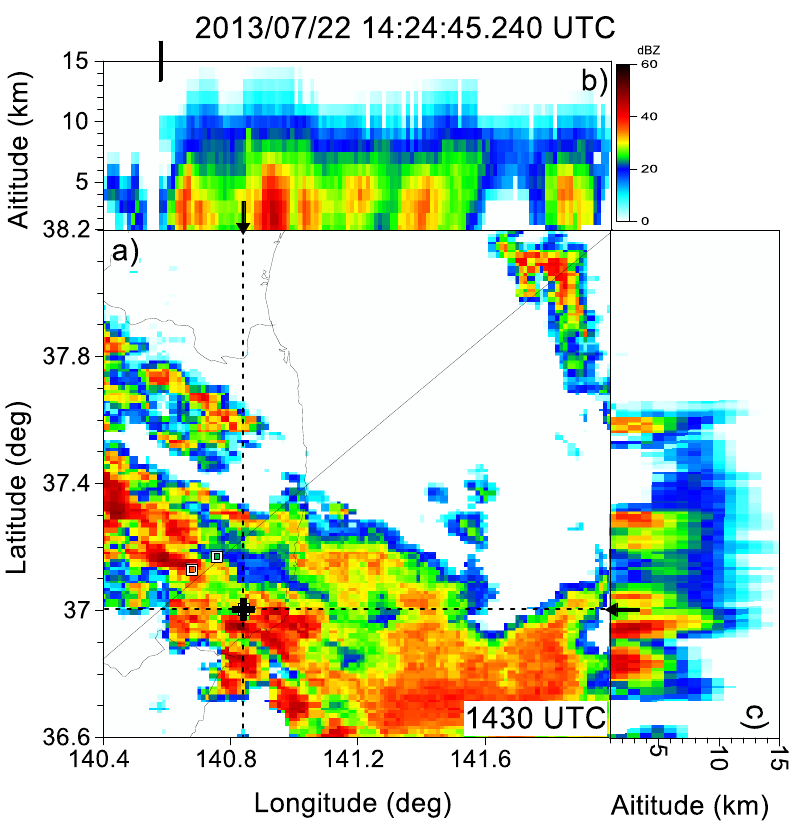
Figure 11. The horizontal and vertical cross-sections of the parent MCS with respect to Sprite 6 at 1424:45.240 UTC. The descriptions ( a – c ) are the same as in Figure 6.